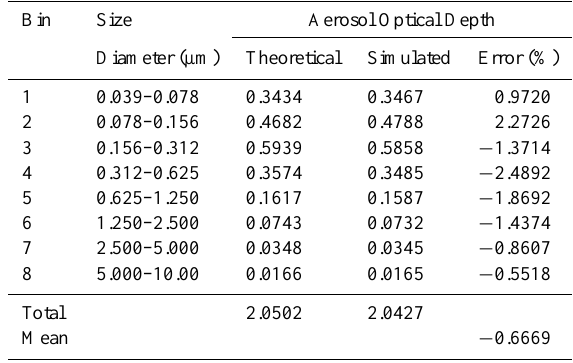
Table 2. Theoretical and calculated AOD at λ = 532nm per size